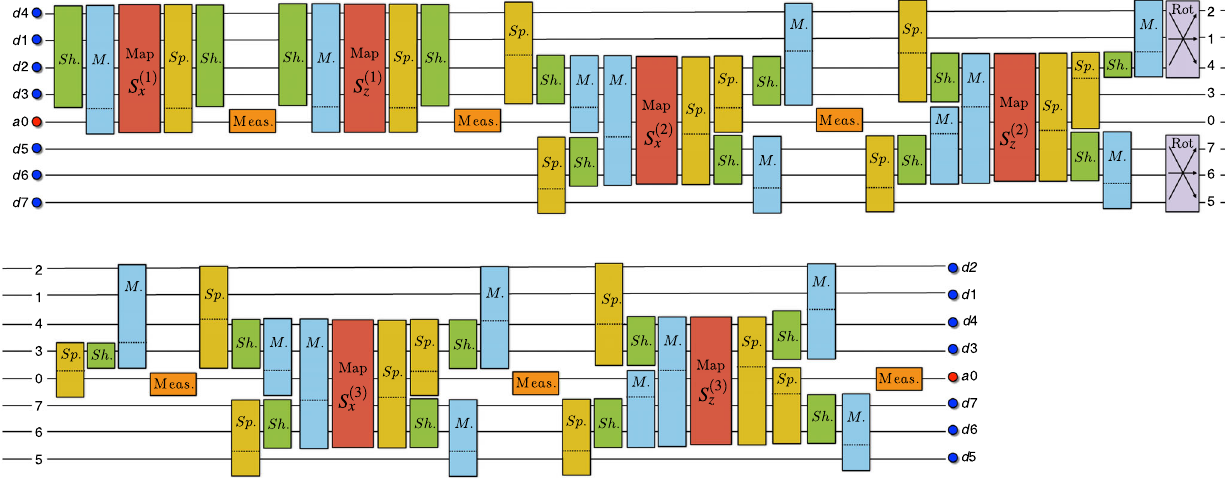
FIG. 16. Circuit representation of shuttling-based one-species QEC cycle with multiqubit MS gates: The data f d 1 ; … ; d 7 g and ancillary a 0 ions are arranged vertically, and a set of boxes represents the elementary operations taking place at a particular time step: “ Sh. ” stands for shuttling of the ions within the green boxes, “ M. ” stands for the merging of the two sets of ions separated by a dotted line within the blue boxes, “ Sp. ” stands for splitting of the crystal into two sets of ions separated by a dotted line within the yellow boxes, “ Meas. ” stands for the ancillary ion measurement in the orange boxes, and “ Rot. ” stands for the rotation of the ion crystal within the purple boxes, with arrows representing the corresponding crystal reordering. Note that some crystal-reconfiguration operations, such as merging or splitting and shuttling, can be operated simultaneously in different trap zones. Finally, Map S ð m Þ α stands for the mapping of a particular stabilizer S ð m Þ α involving the data and ancillary ions within the red boxes. These red boxes contain the sequence of quantum gates in Fig.